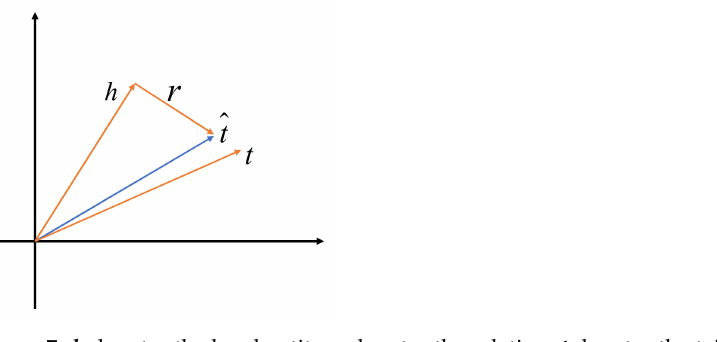
Figure 7. h denotes the head entity, r denotes the relation, t denotes the tail entity, and ˆ t denotes a real representation of h+r in the vector